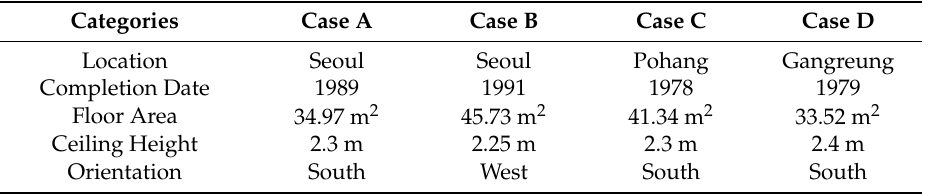
Table 1. Overview of the studied buildings.